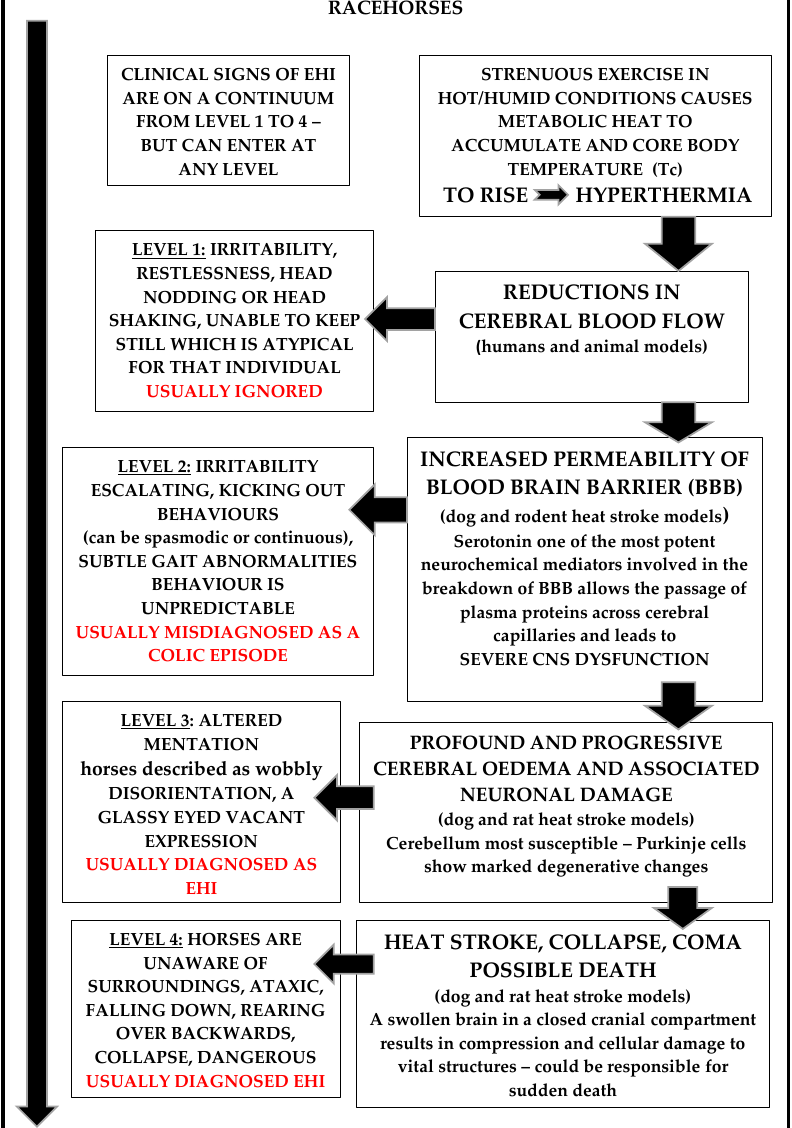
Figure 8. Case definition of EHI in TB racehorses and the postulated associated CNS pathology. Note that Levels 1 to 4 are on a continuum, but horses may enter at any level. Level 1 is the most important to recognise and is the most often misdiagnosed. Early recognition of EHI is essential because early treatment interventions enable the best outcomes